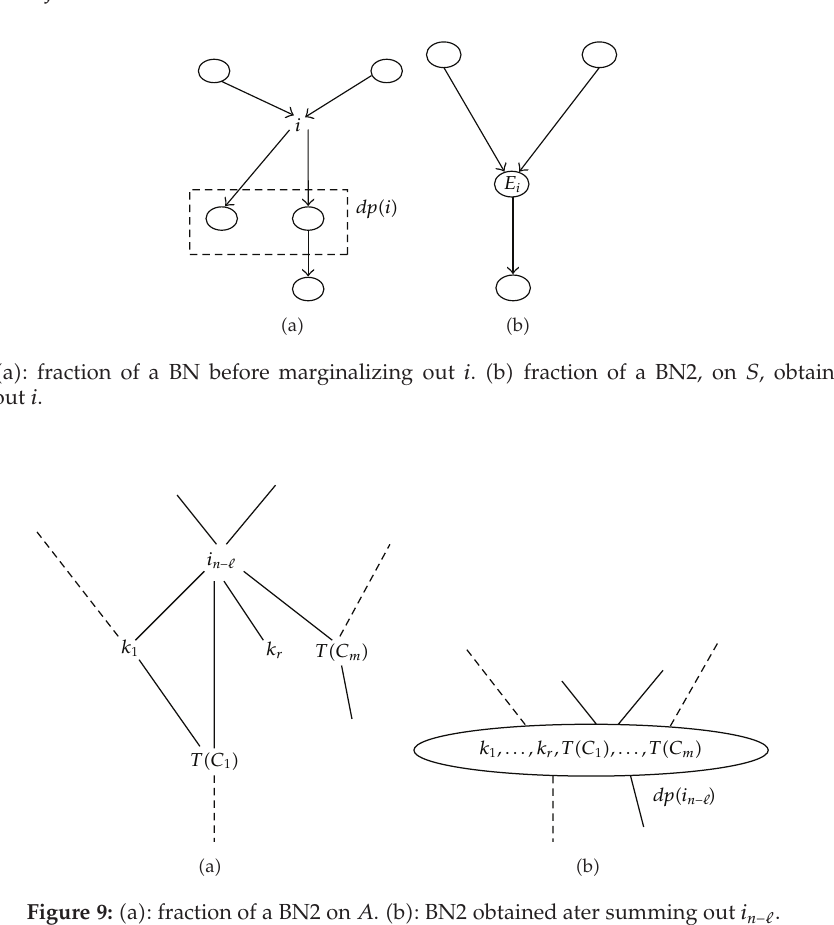
Figure 9: (cid:5) a (cid:6) : fraction of a BN2 on A . (cid:5) b (cid:6) : BN2 obtained ater summing out i n − (cid:2)